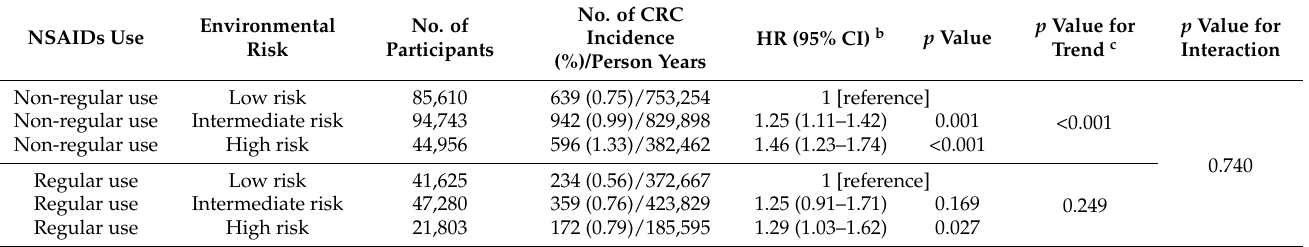
Table 4. The CRC incidence risk in accordance with environmental risk categories according to NSAID use a